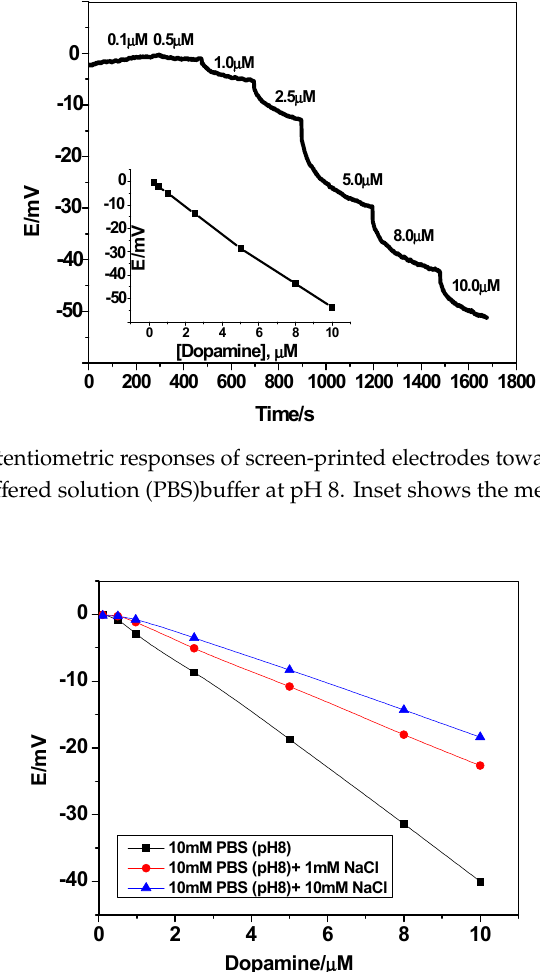
Figure 6. Potentiometric response of the proposed sensor at different chloride concentrations in 10-mM PBS buffer of pH 8.